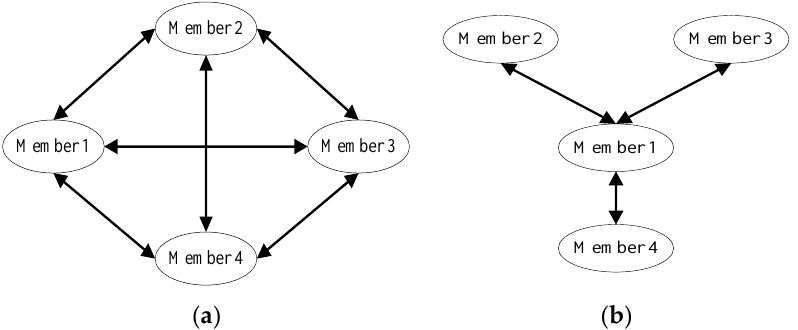
Figure 1. ( a ) Alliance without communication structure restrictions; ( b ) alliance with communica- tion structure restrictions. structure